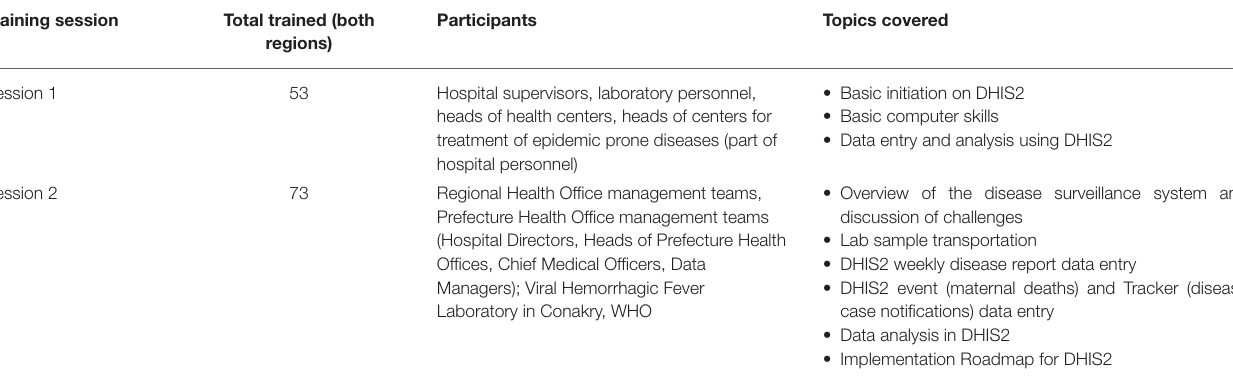
TABLE 2 | DHIS 2 training in both Boké and Labé by session, participant type, and topics covered. Training